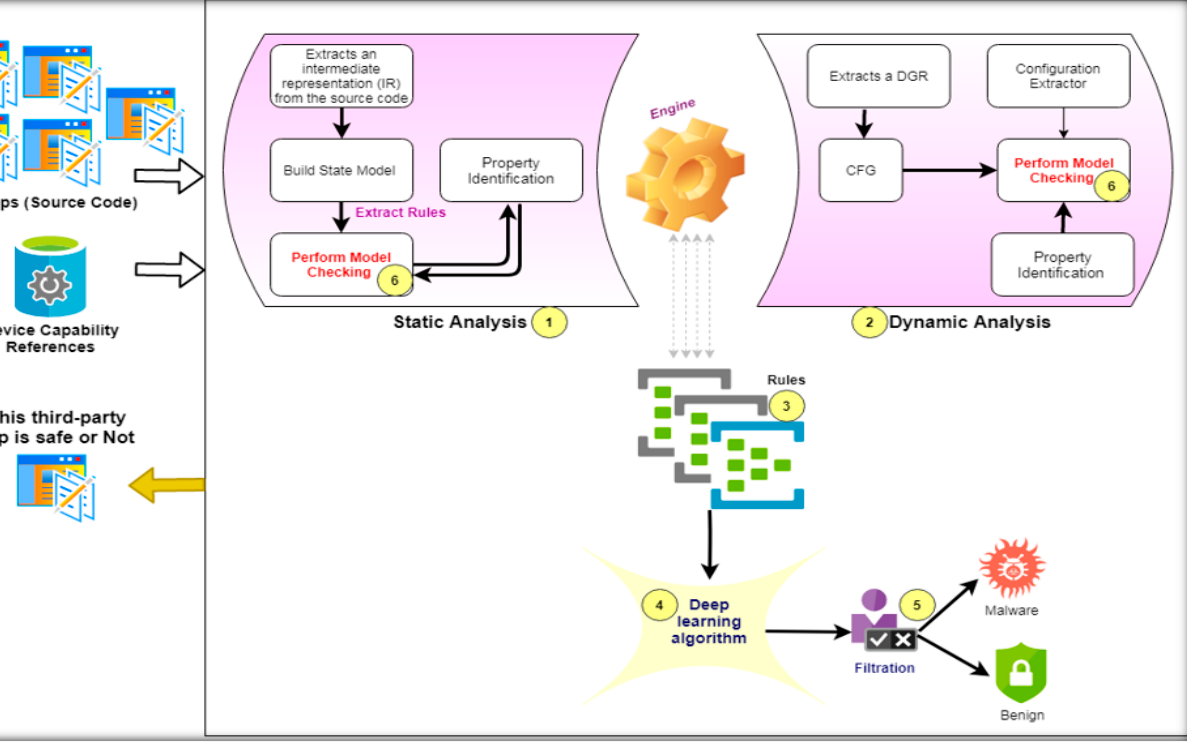
Figure 6. HSAS-MD Analyzer Architecture.